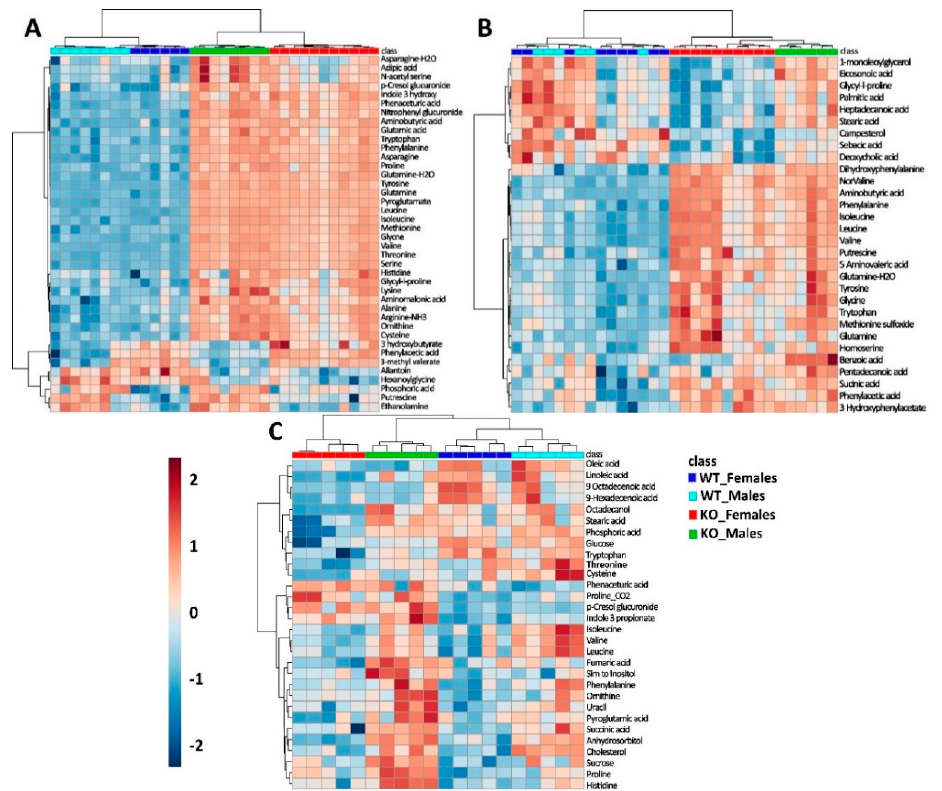
Figure 3. A two-way hierarchal cluster analysis (HCA) and heat map of metabolite differences in urine ( A ), faeces ( B ) and plasma ( C ) of SLC6A19ko and SLC6A19wt mice. Unsupervised HCA and heat